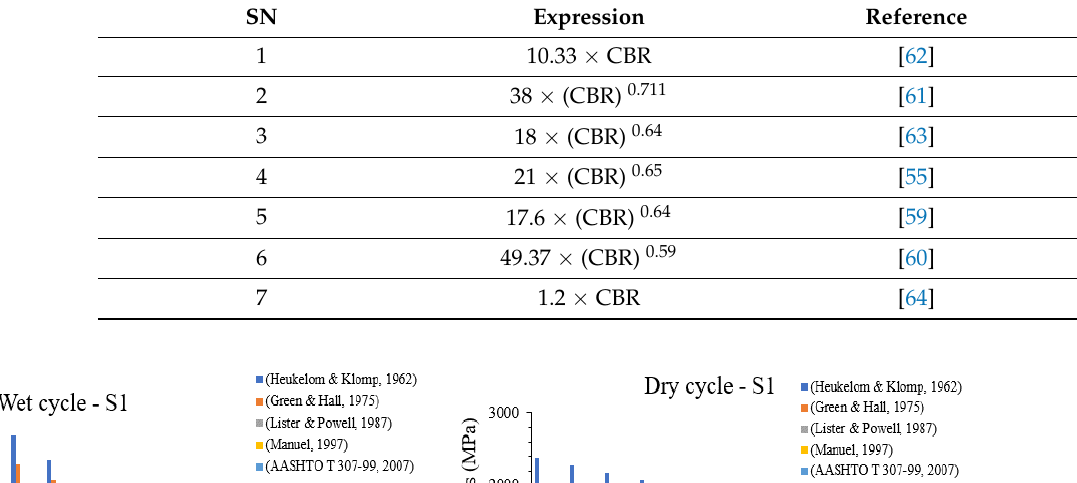
Table 2. Empirical Relationship for Resilient Modulus Derivation.